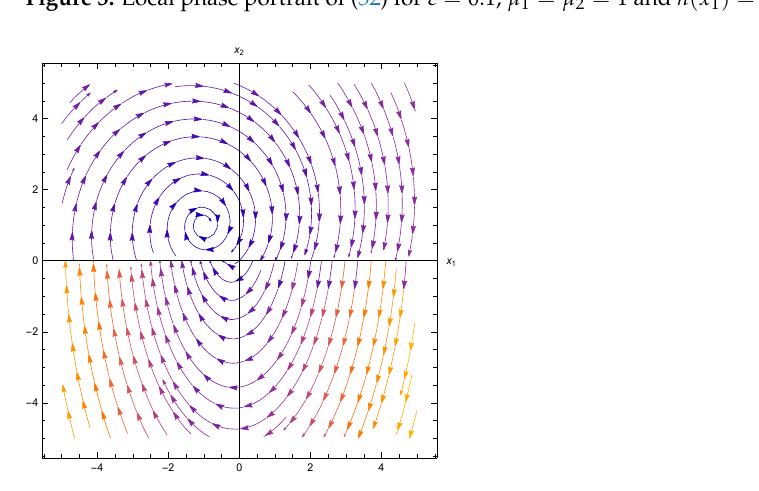
Figure 4. Local phase portrait of (52) for ε = 0.1, µ 1 = 1, µ 2 = − 1 and h ( x 1 ) = x 1 +